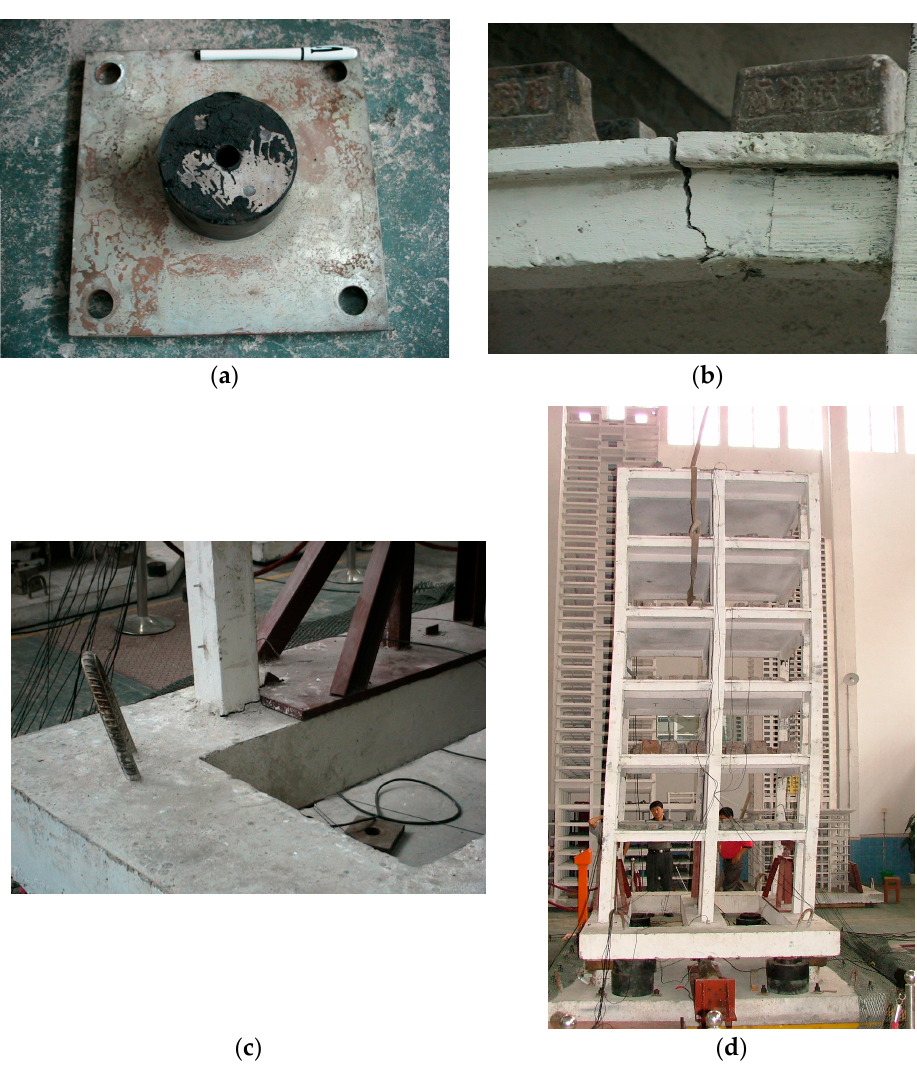
Figure 19. The structure destruction. ( a ) the isolation bearing failure; ( b ) the beam failure of model structure; ( c ) the bottom column failure of model structure; ( d ) the overall failure of model structure.